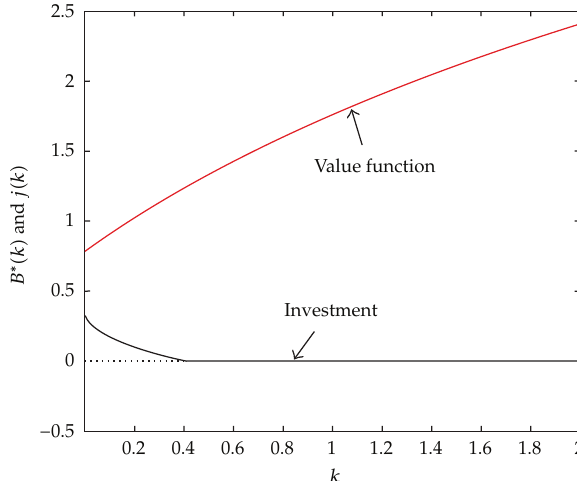
Figure 1: Quadratic adjustment cost of